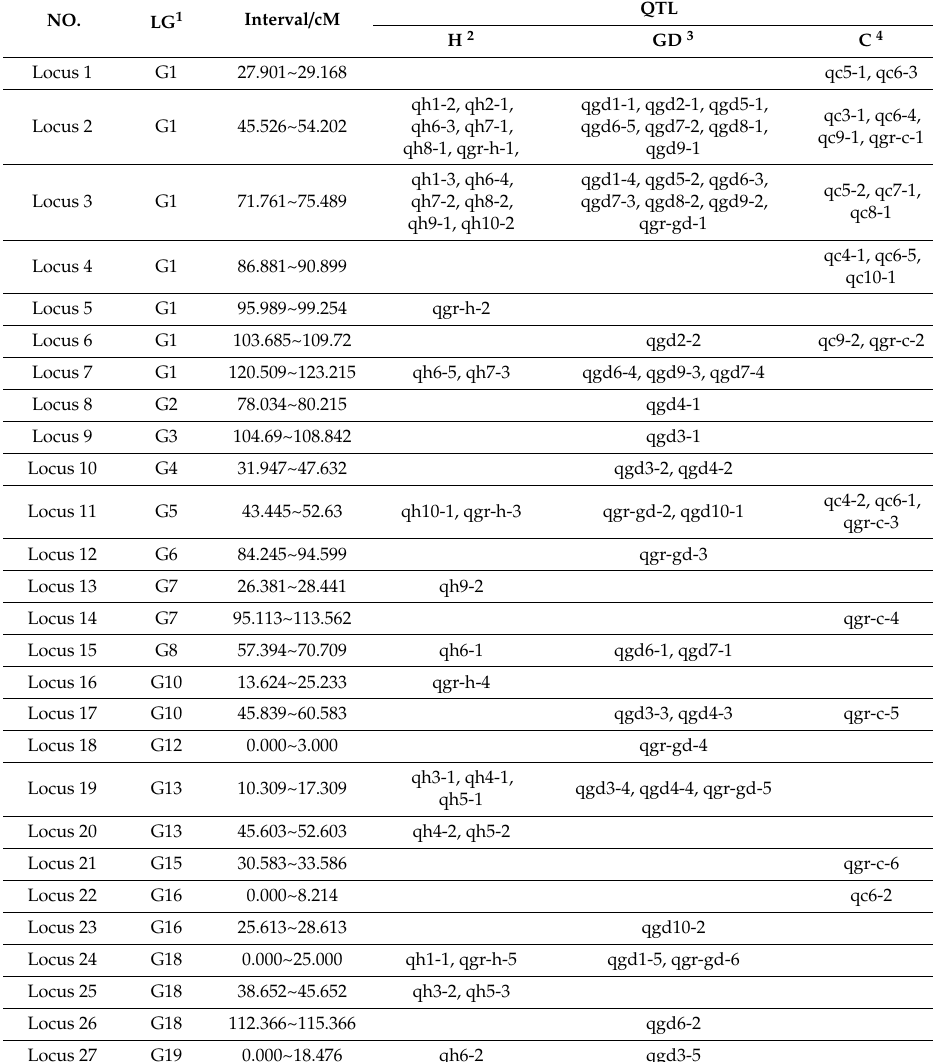
Table 4. The statistics of QTL loci on the genetic linkage